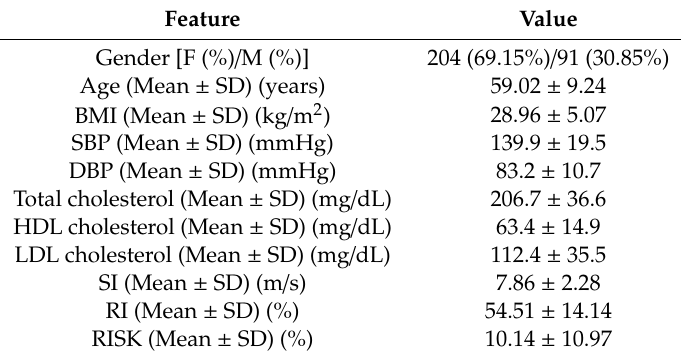
Table 1. Group characteristics. F = female, M = male, SD = standard deviation, BMI = body mass index, SBP = systolic blood pressure, DBP = diastolic blood pressure, SI = sti ff ness index, RI = reflection index, RISK = cardiovascular risk based on ACC / AHA Heart Risk